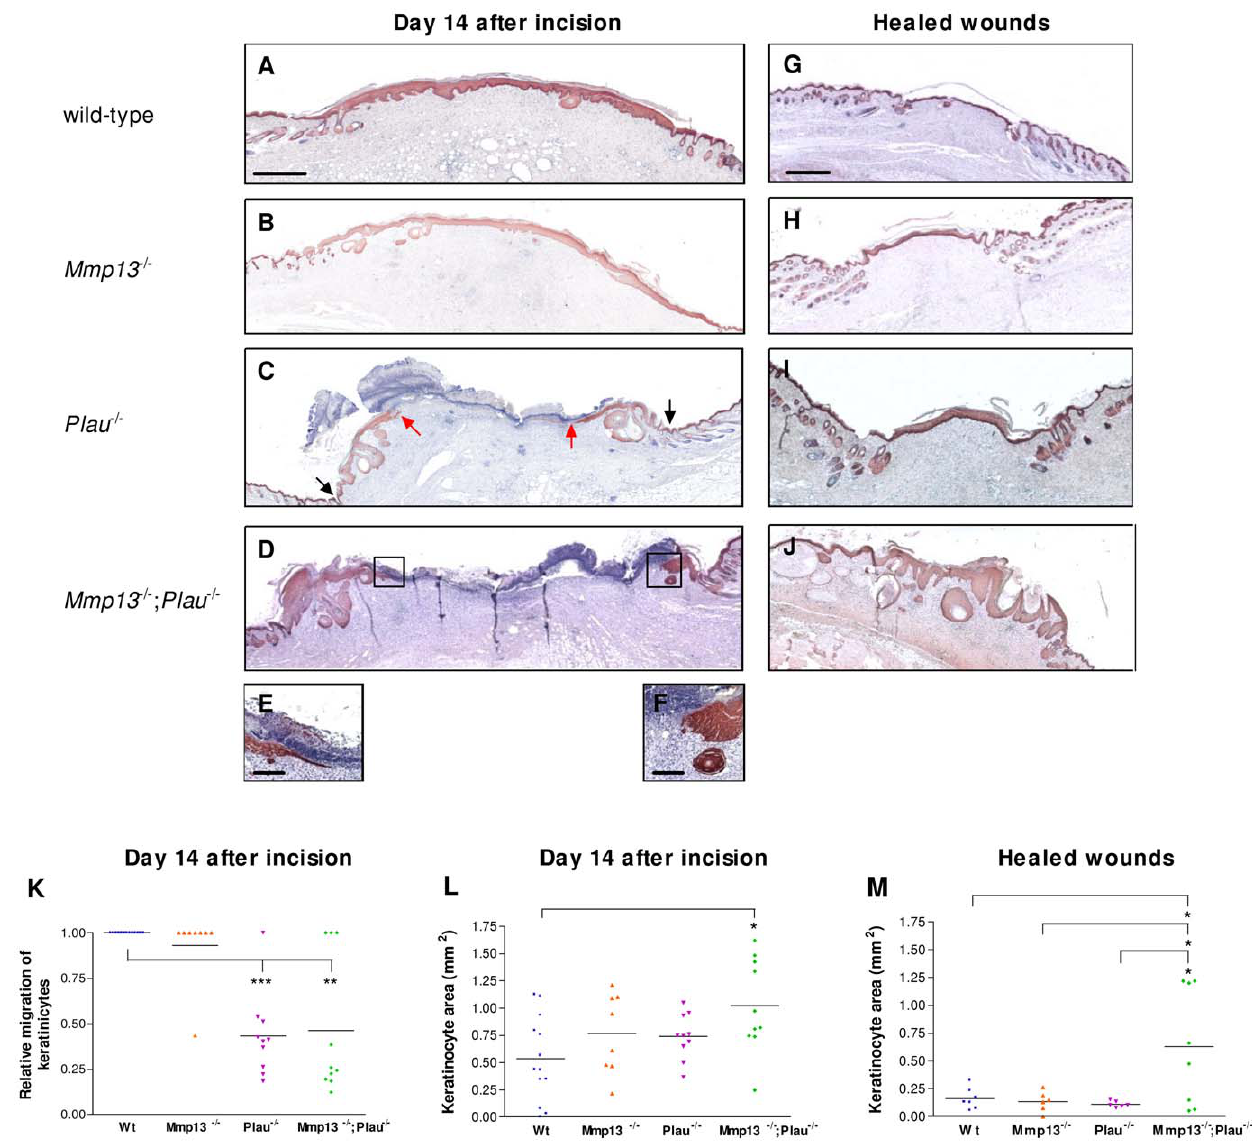
Figure 3. Kinetics of re-epithelialization in skin wounds in Mmp13;Plau double-deficient mice. Re-epithelialization of wounds is visualized by immunostaining of keratinocytes with anti-mouse keratins 10 and 14 in wild-type ( A + G ), Mmp13 -deficient ( B + H ), Plau -deficient ( C + I ) and Mmp13;Plau double-deficient ( D + J ) mice. ( C ) black arrows mark the wound edge and red arrows point to the tip of the leading edge keratinocytes. Scale bar =0.5 mm, except for ( E + F ) (insets of D showing the leading edge keratinocytes) where scale bare =0.2 mm. ( K ) Quantitative evaluation of the relative migration distance of keratinocytes measured at day 14 after incision. With this method, complete re-epithelialization is scored as 1.0 and each data point refers to an individual wound. The mean values are depicted as horizontal lines. ( L + M ) Quantitative evaluation of the area of the multilayered epidermal layer measured from the wound edge to the leading edge kerationocytes by computerassisted morphometry. Differences in experimental groups are measured by a two-tailed unpaired t-test. *p # 0.05; **p # 0.01; ***p # 0.001).